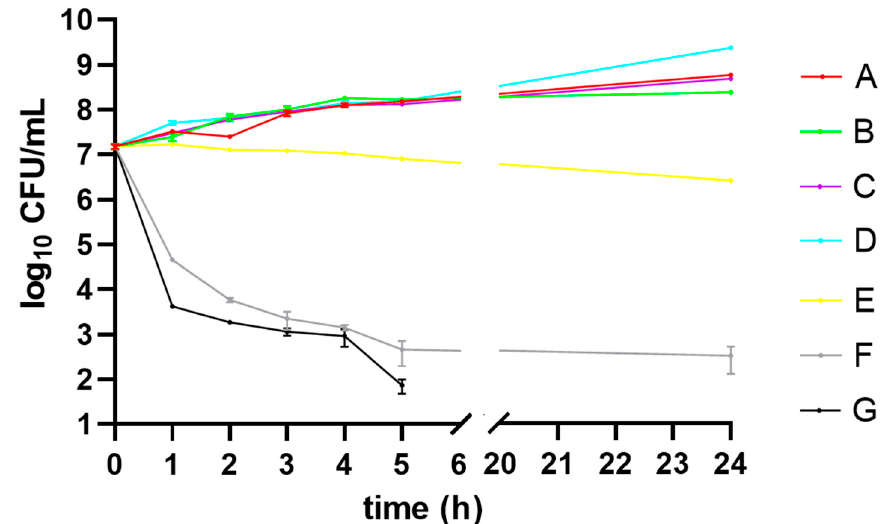
Figure 2. Time-kill kinetics of Staphylococcus aureus ATCC 43300 (MRSA) strain grown in Mueller-Hinton broth containing: no chemicals (control—medium A), Tween 80 (medium B), DMSO (medium C), Tween 80 and DMSO (medium D), lavender essential oil (LEO) at subinhibitory concentration (MIC 50 ) (medium E), octenidine dihydrochloride (OCT) at subinhibitory concentration (MIC 50 ) (medium F), LEO/OCT at subinhibitory concentrations (MICc 50 ) (medium G). CFU—colony forming unit.